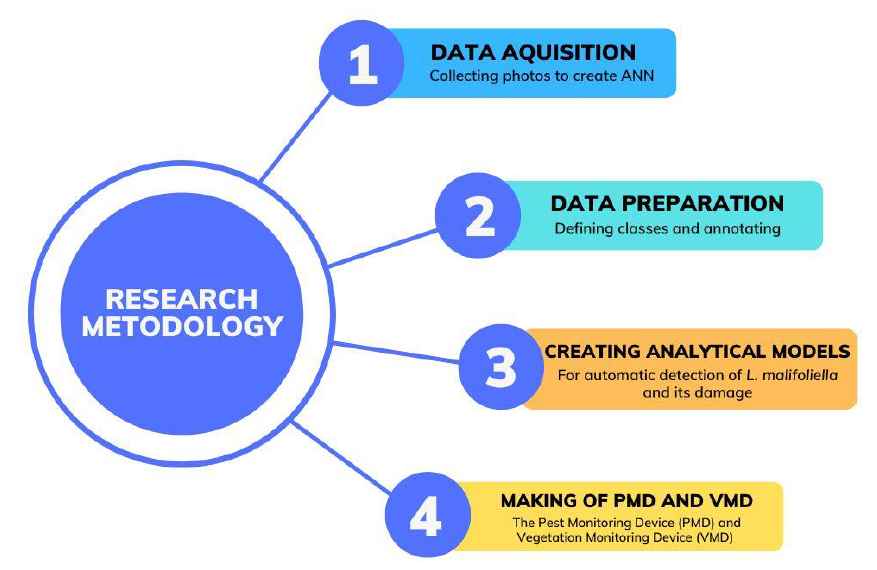
Figure 1. The methodology of the study .